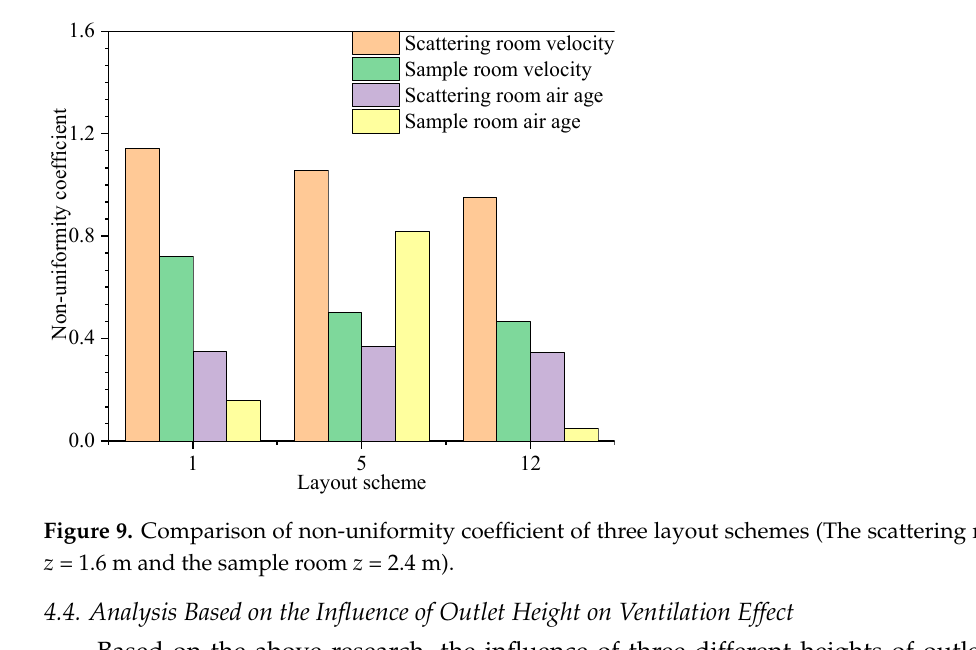
Scattering room Sample room Figure 8. Comparison of average air age of three layout schemes (The scattering room z = 1.6 m and the sample room z = 2.4 m). Figure 9 shows the comparison of velocity and air age under the non-uniformity co- efficient. It can be seen from Figure 9 that the velocity non-uniformity coefficient is the smallest in the scattering room and sample room of layout scheme 12. The velocity non- uniformity coefficient of the scattering room in layout schemes 1 and 5 are 11 and 20 per- cent, respectively, higher than that in layout scheme 12. Moreover, their velocity non-uni- formity coefficient of sample room is 54 and 7 percent, respectively, and more heightened